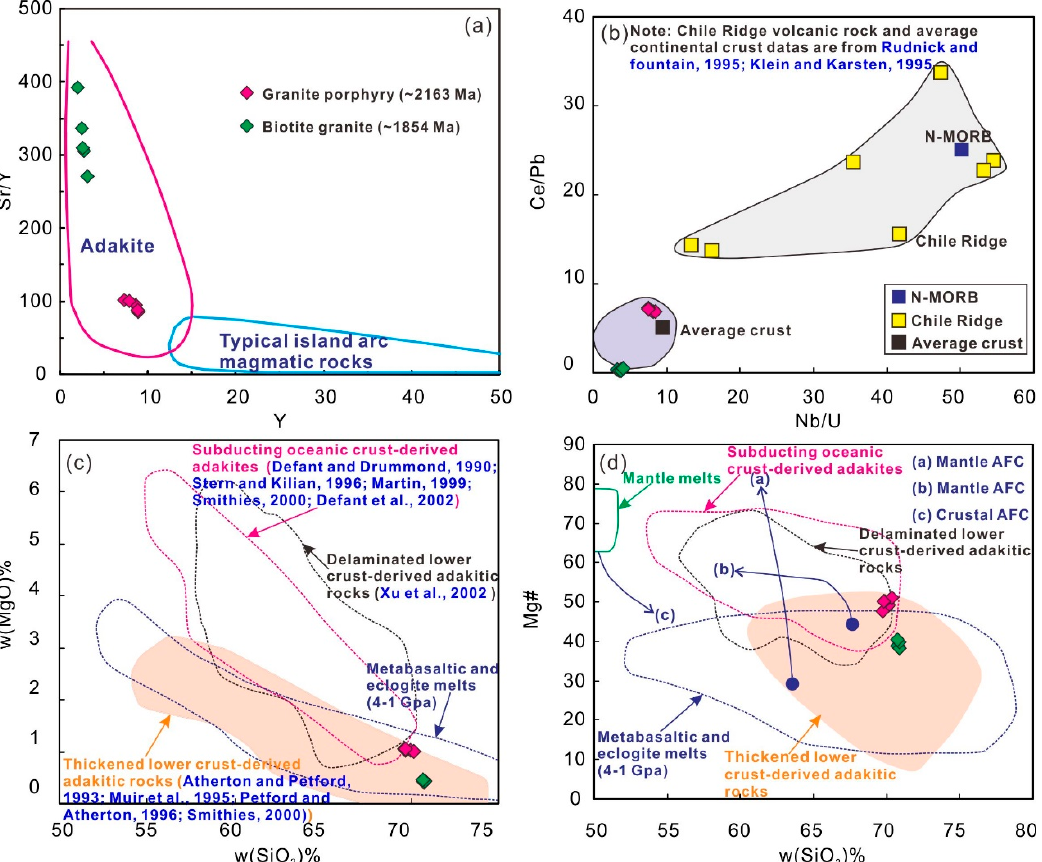
Figure 10. Discrimination diagrams of Paleoproterozoic adakitic rocks in the Qingchengzi district. ( a ) Sr/Y vs. Y (after Defant and Drummond [61]; Martin [63]); ( b ) Ce/Pb vs. Nb/U (Chile Ridge volcanic rock and average continental crust data are from Klein and Karsten [72], Rudnick and Fountain [73], Muir et al. [74]); ( c ) MgO vs. SiO 2 ; ( d ) Mg # vs. SiO 2 .